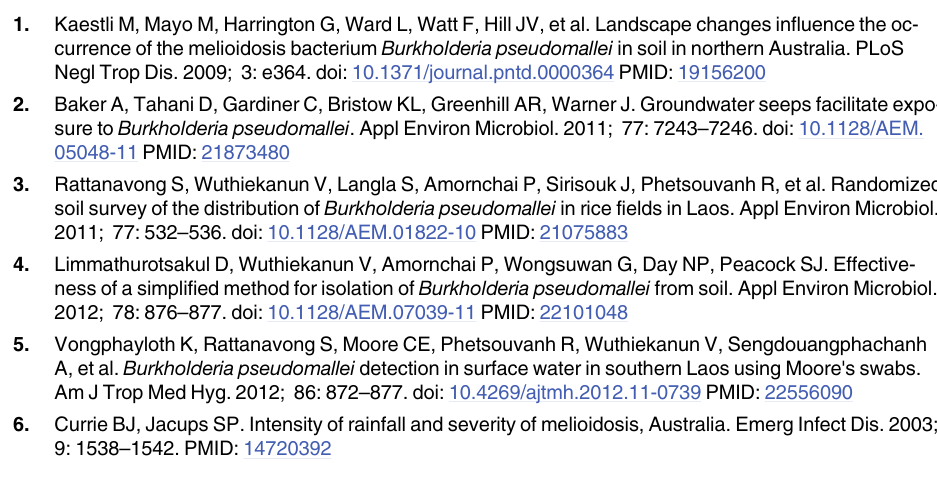
S2 Fig. Phylogenetic analysis of PFGE patterns. With 90% similarity, the B . pseudomallei iso- lates (S, soil isolates; H, human isolates; A, aerosol isolates) in this study were organized into Groups I and II. Group I was subdivided into Groups Ia, Ib and Ic. The ST types of each isolate are shown at the bottom of this figure. S1 Table. Targets, primer sequences and PCR conditions. S2 Table. Location and isolation rate of sample sites. S3 Table. The location and PCR positive rates of aerosols at air sampling sites. S4 Table. Strain information, ST types and alleles of B. pseudomallei